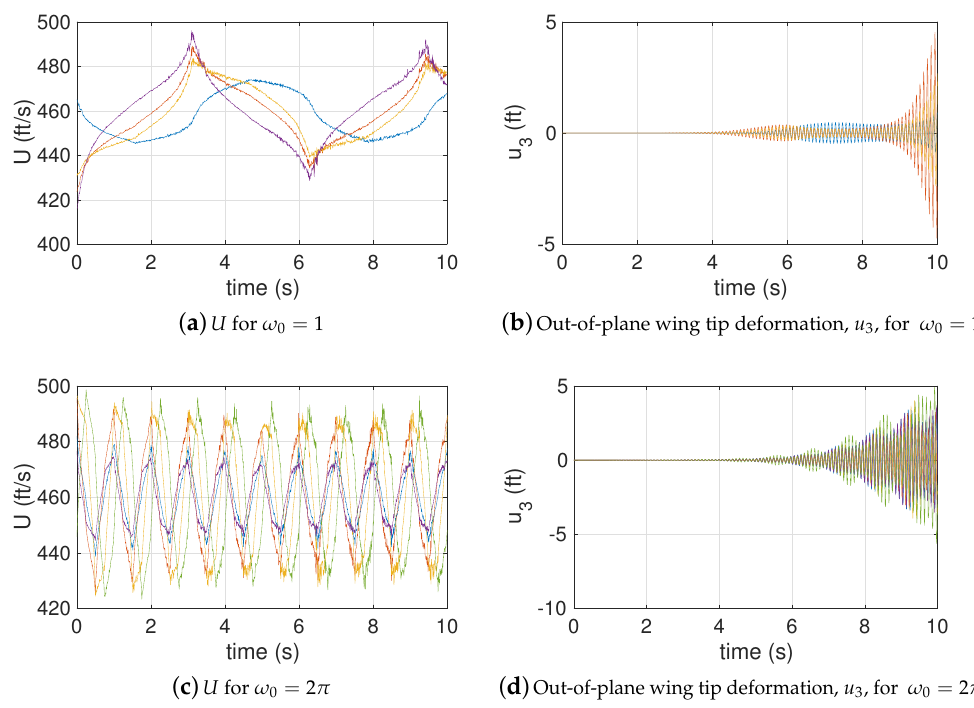
Figure 25. Goland Wing Oscillation with correlation function, r xx = Cos ( ω 0 τ ) , ∆ = 0.1, and U ave = 460